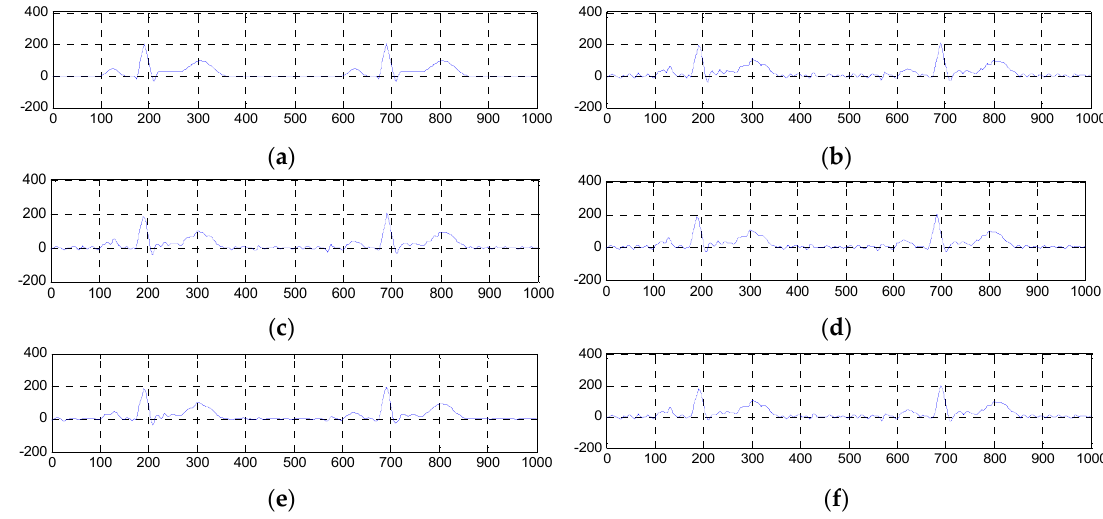
Figure 9. Comparison of denoised results of the ESMD-NLM method, the NLM method, the EEMD method and the VMD method operating on the simulated ECG signal corrupted by muscle artifact noise with the variance of 60. ( a ) The original ECG signal, ( b ) the noisy ECG signal (muscle artifact noise, σ 2 = 60), ( c ) the ESMD-NLM method, ( d ) the EEMD method, ( e ) the NLM method, ( f ) the VMD method.